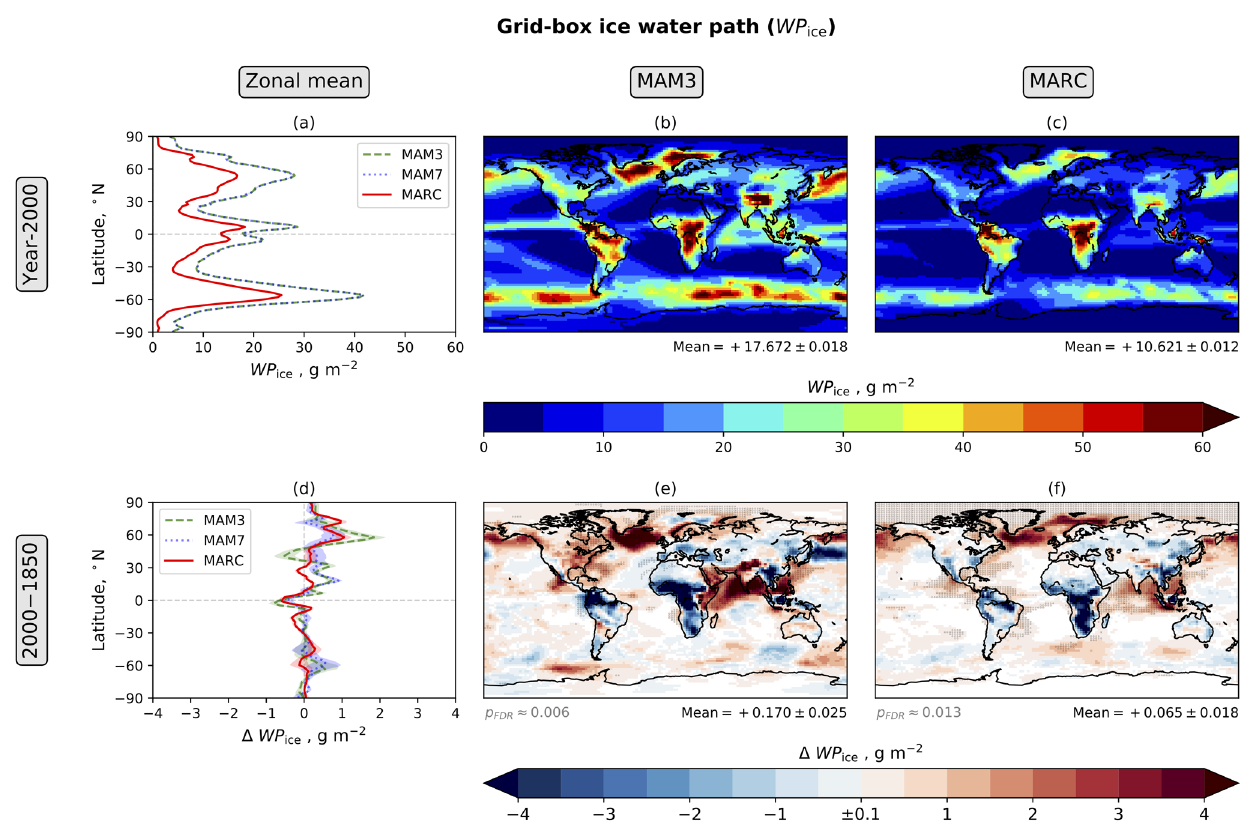
Figure 13. Annual mean grid-box cloud ice water path (WP ice ). The figure components are explained in the Fig. 2